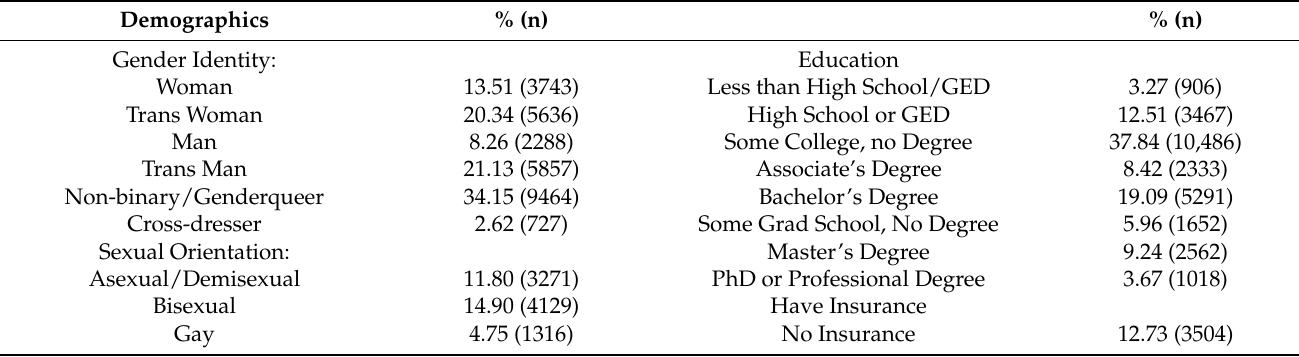
Table 1. Sample demographics (total N =